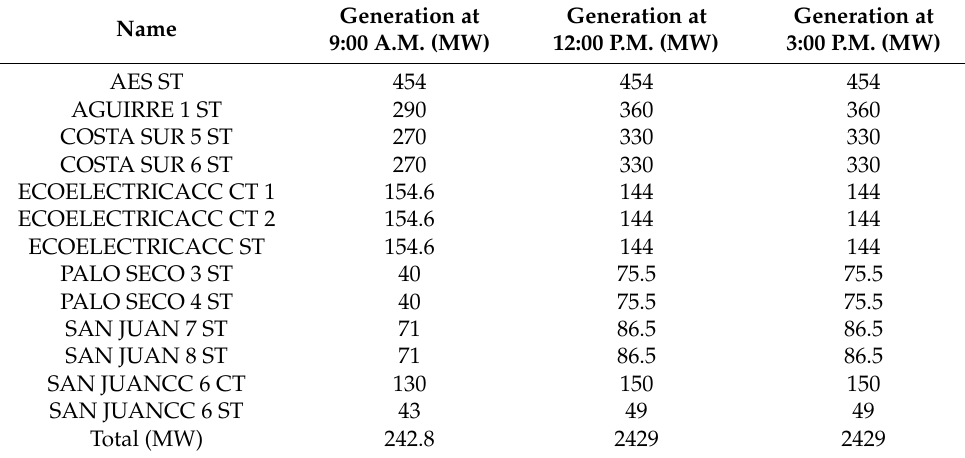
Figure 11. Typical weekday normalized load shape in Puerto Rico (Data from [27]). Table 11. Typical generation dispatches used for the validation